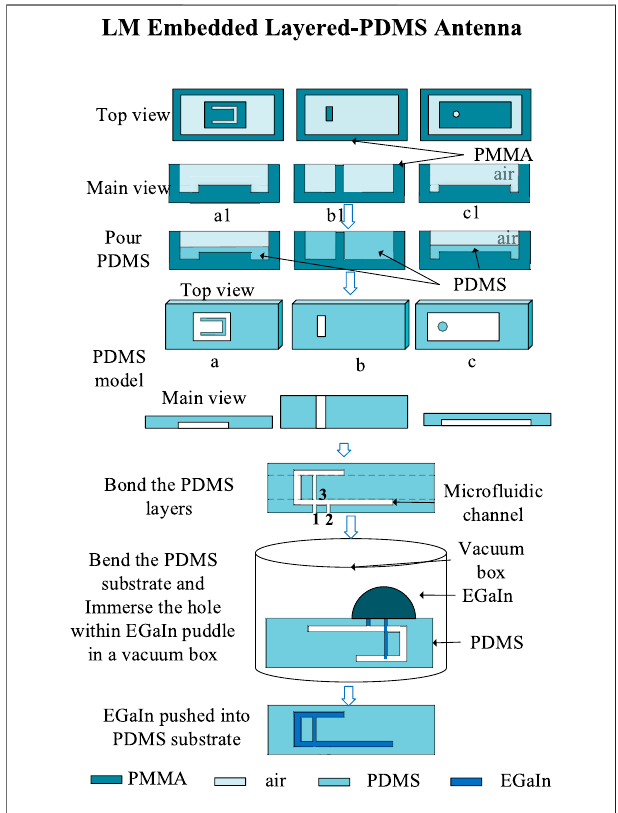
FIGURE 3 | Steps for fabricating the wearable